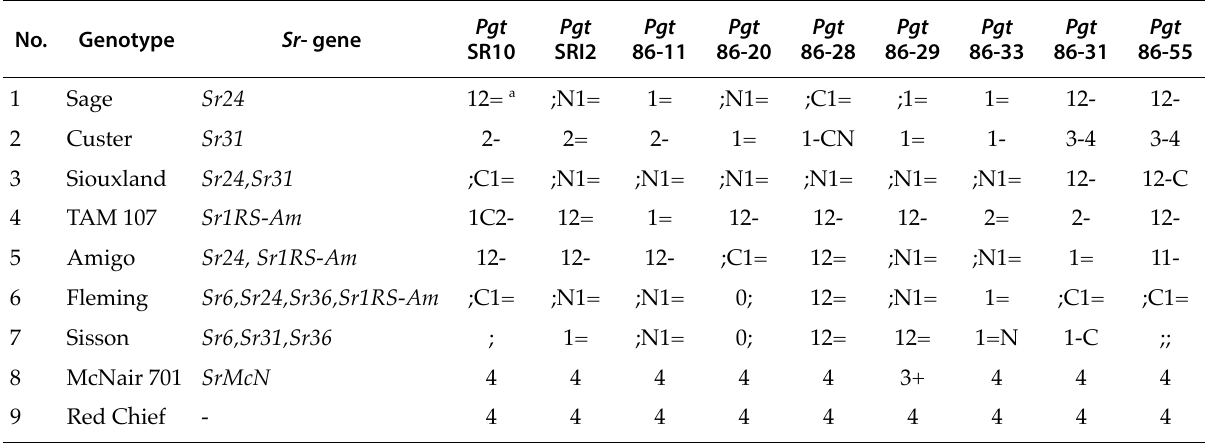
Table 4. Seedling infection type of nine Puccinia graminis f. sp. tritici collections on additional sources of stem rust resistance